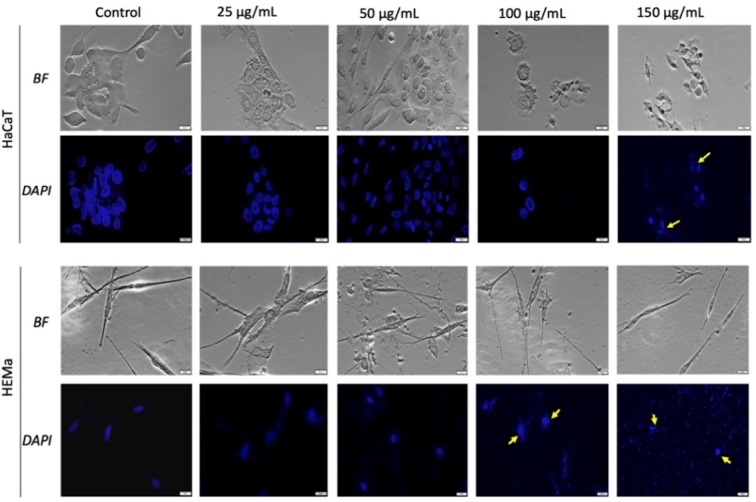
Healthy - HaCaT and HEMa cells treated with SCMIOPs at different concentrations (25, 50, 100, and 150 µg/ml) for 24 h. Bright field (BF) microscopy was employed to analyze morphological changes; DAPI staining (blue) was performed to evaluate cell nuclei modifications. Scale bars represent 20 µm.